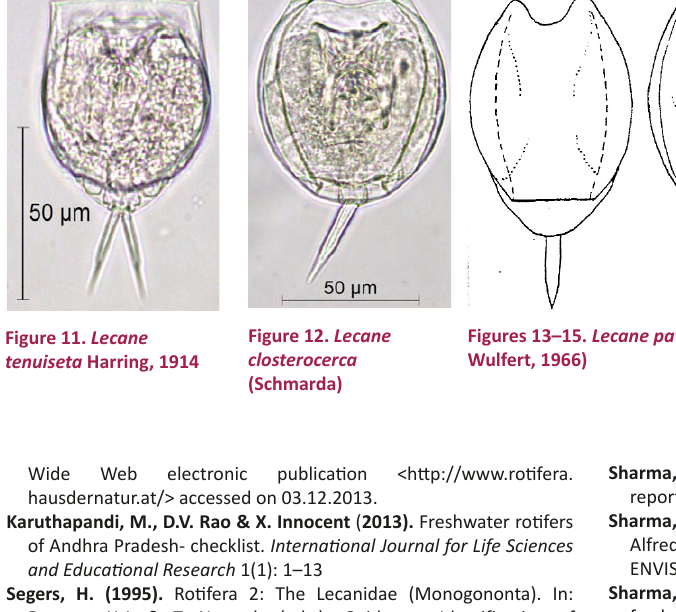
Figure 10. Lecane furcata (Murray)